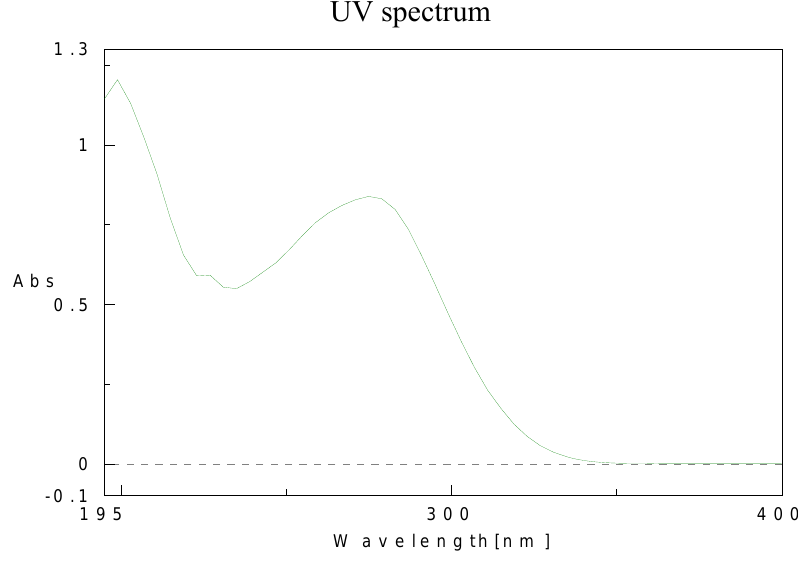
( E )-Methyl 3-([1,1'-biphenyl]-4-yl)but-2-enoate [( E )-1c] White solid (Mp = 135.3-137.0 °C). 0.19 ( n -hexane/ethylacetate 99:1); 1 H-NMR (CDCl )  ppm): 2.65 (d, 3H, J = 1.2 Hz), R f 3 3.80 (s, 3H), 6.24 (q, 1H, J = 1.3 Hz), 7.37-7.42 (m, 1H), 7.45-7.51 (m, 2H), 7.57-7.67 (m, 6H); HPLC-UV/PAD analysis: RT 6.7 min. UV spectrum 1 .4